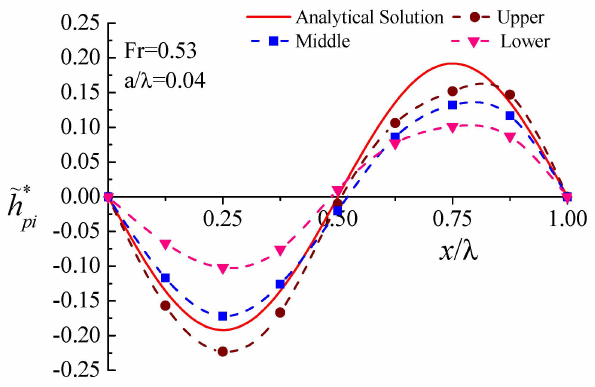
Figure 3. Analytical solutions compared with experimental data in different layers under the Run2 case, in which the solid line represents the analytical solution, while dashed lines dotted with round points, rectangle points and triangle points correspond to the upper, middle and lower layers,